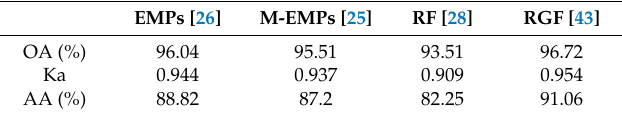
Table 6. Initial classified image acquired by different spectral–spatial approaches and the SVM classifier for the Pavia Center image. EMPs: extended morphological profiles, M-EMPs: multi-shape extended morphological profiles, RF: recursive filter, RGF: rolling guidance filter.